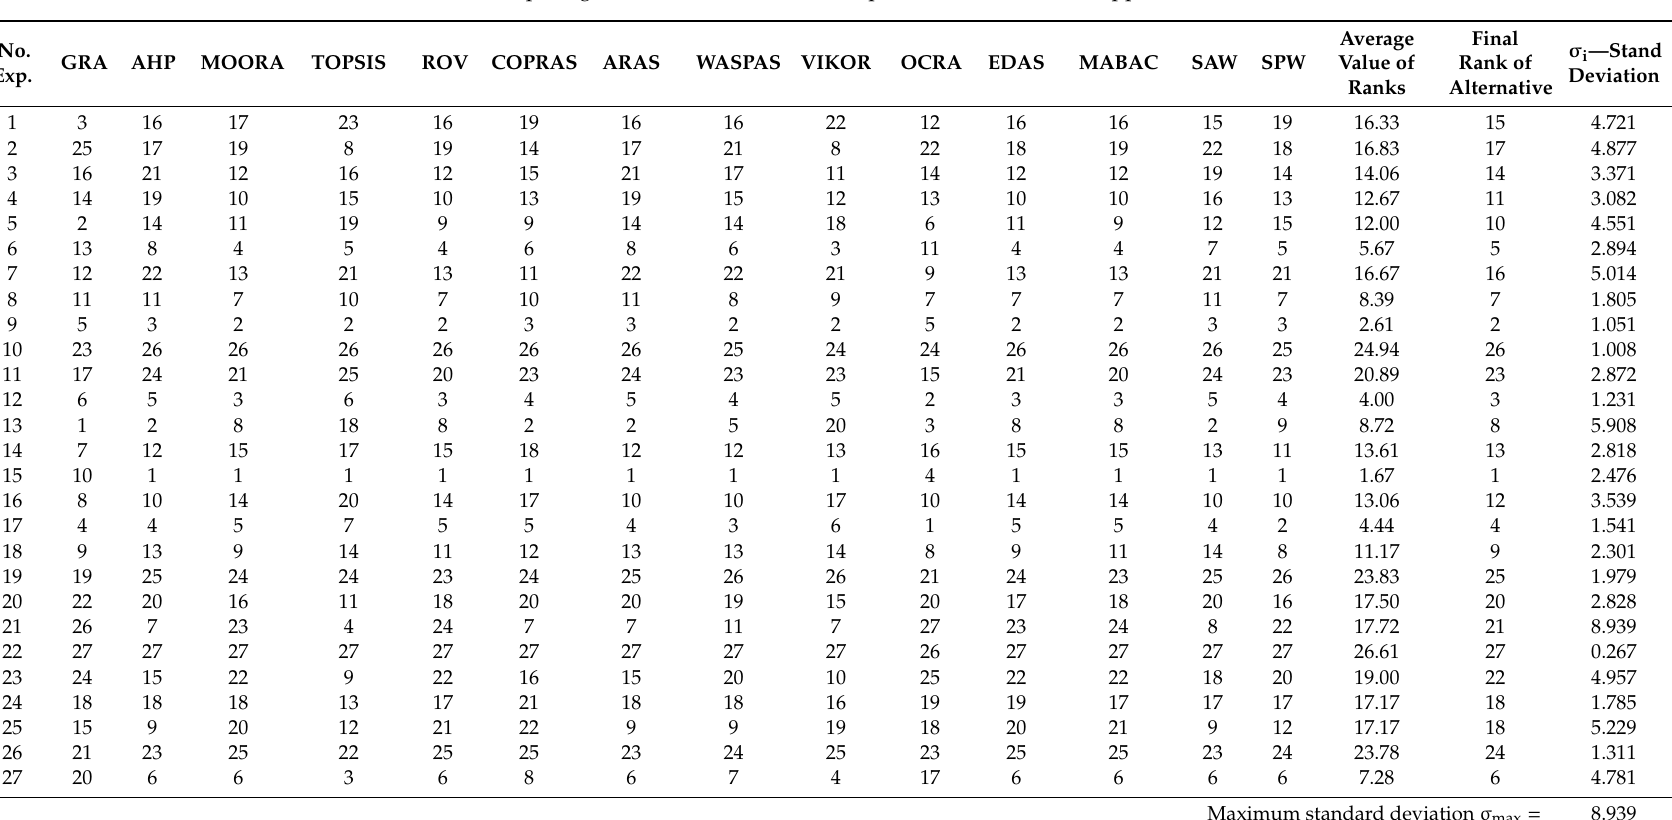
Table 7. Results of comparing the ranks of the alternative parameter levels of the applied MCDM